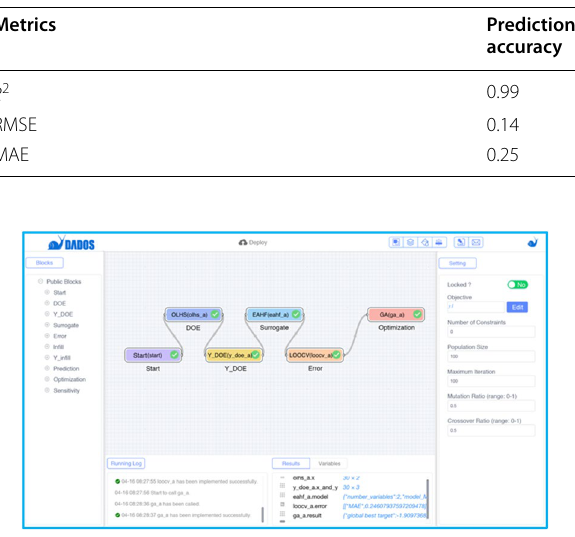
Figure 16 Configuration of the GA block for the numerical